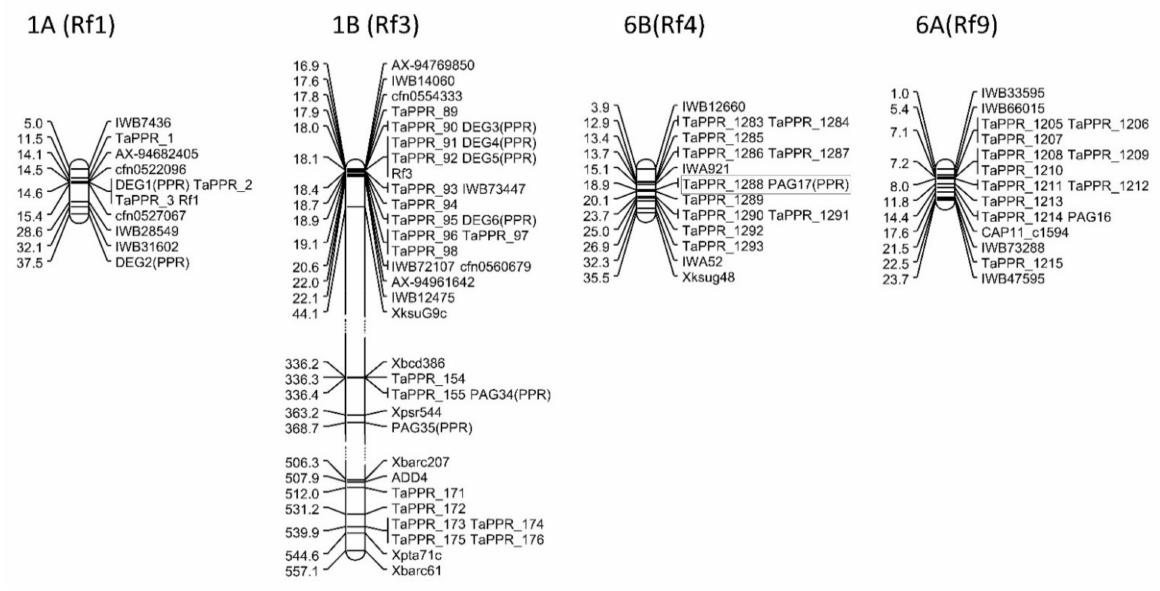
Figure 5. Physical maps of the Rf1 , Rf3 , Rf4 , and Rf9 loci with co-localized DEGs and PAGs. Marker positions are provided in Mbp. TaPPR markers refer to annotated PPR genes (URGI). The DEGs and PAGs that were localized within any Rf locus are